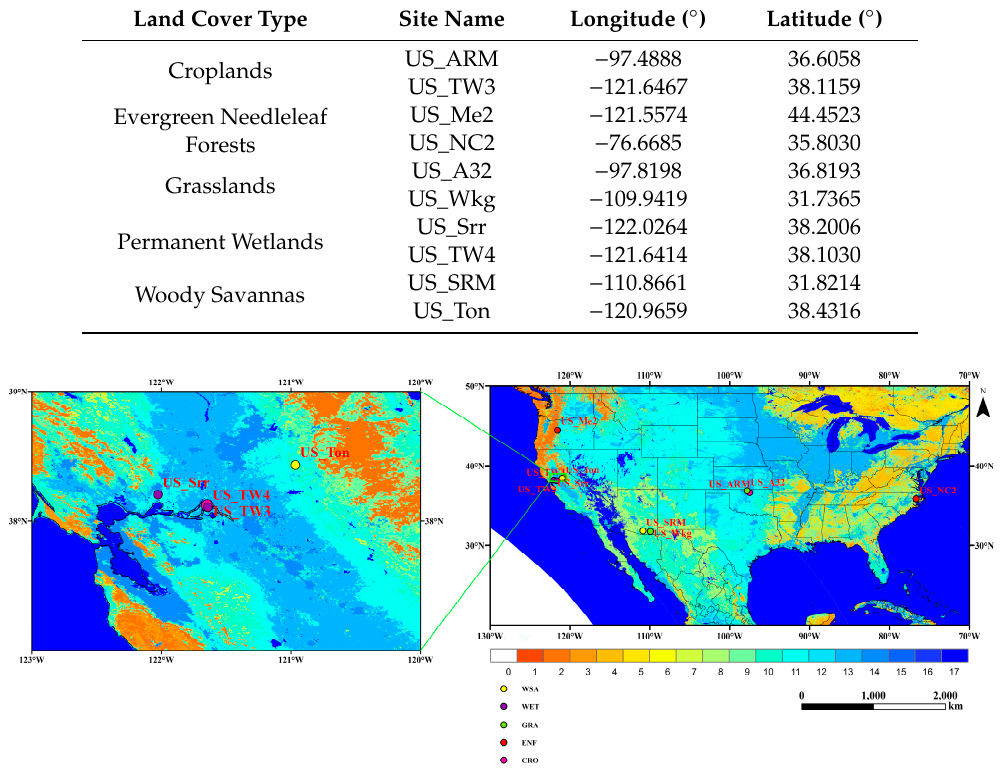
Figure 1. Land cover map of the study area from MCD12Q1 based on the International Geosphere-Biosphere Program (IGBP) classification and the AmeriFlux sites used in this study. 1 indicates that the land cover type is ENF (evergreen needleleaf forests), 2: EBF (evergreen broadleaf forests), 3: DNF (deciduous needleleaf forests), 4: DBF (deciduous broadleaf forests), 5: MF (mixed forests), 6: CSH (closed shrublands), 7: OSH (open shrublands), 8: WSA (woody savannas), 9: SAV (savannas), 10: GRA (grasslands), 11: WET (permanent wetlands), 12: CRO (croplands), 13: UBL (urban and built-up Lands), 14: CRO/NVM (cropland/natural vegetation mosaics), 15: PSI (permanent snow and ice), 16: barren, 17: water bodies, 0: unclassified.